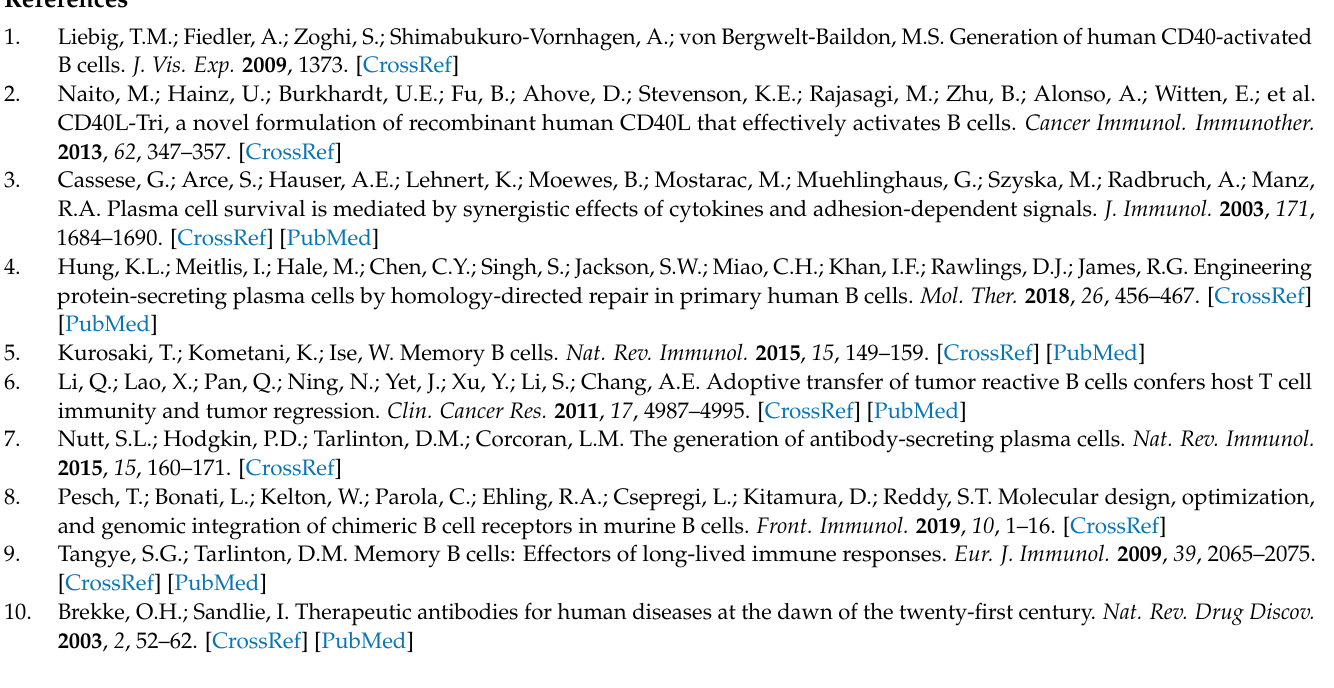
growth medium, Figure S2: Representative histograms of GFP expression 48 h post-transfection, Figure S3: Correlation between the level of GFP expression and the level of propidium iodide (PI) incorporation, Table S1: Polymer densities and polymer concentrations used for the transfection under standard conditions (6-well plate protocol), Table S2: Transfection of human primary B cells with l-PEI using the tube transfection